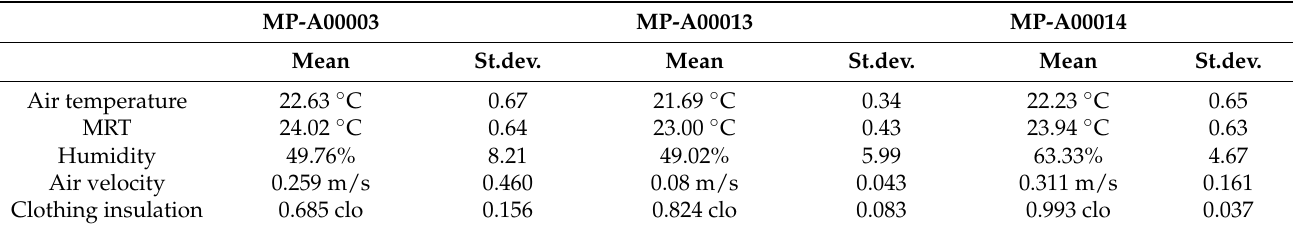
Table 5. Average values in the monitoring period for the three